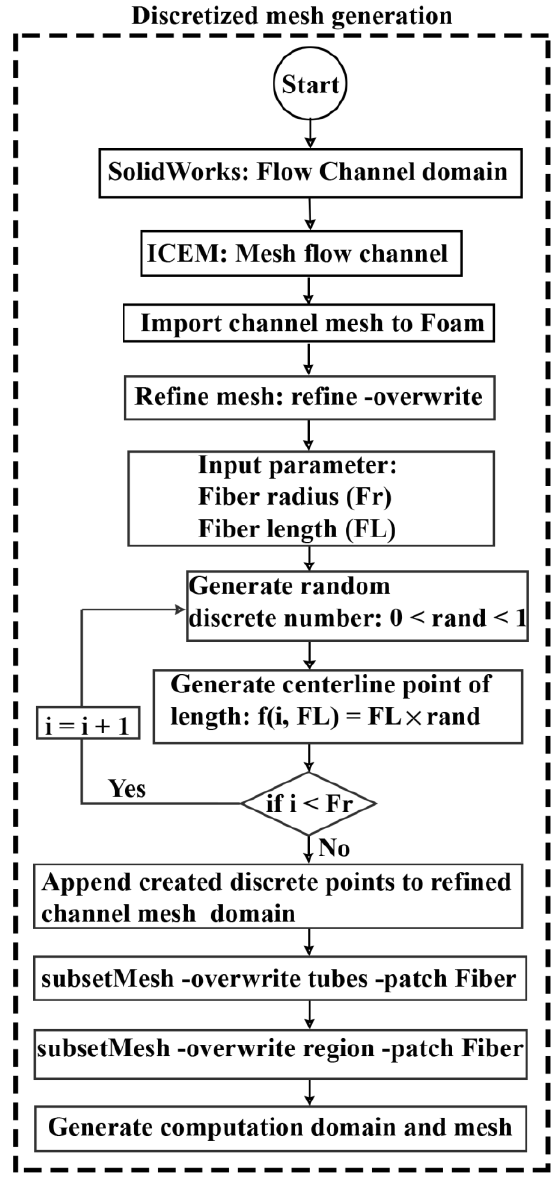
Figure 1. Algorithmic approach employed in discretization of the GDL-channel domain.